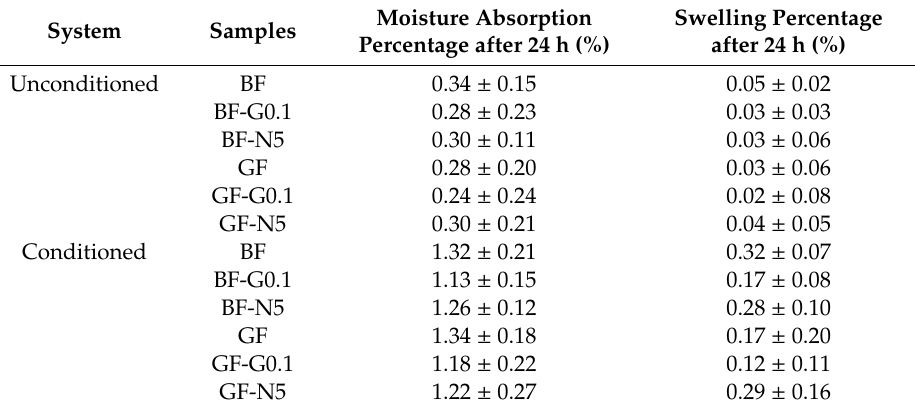
Table 2. Water absorption and swelling behavior of BFRP